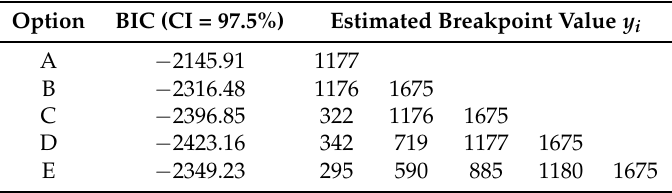
Table 1. The Bayesian information criterion (BIC) criterion, Bai–Perron test and the corresponding breakpoints options (A–E) in the daily ethanol time series (TS) based on the Center for Advanced Studies on Applied Economics/University of Sao Paulo (CEPEA) methodology. Option BIC (CI =